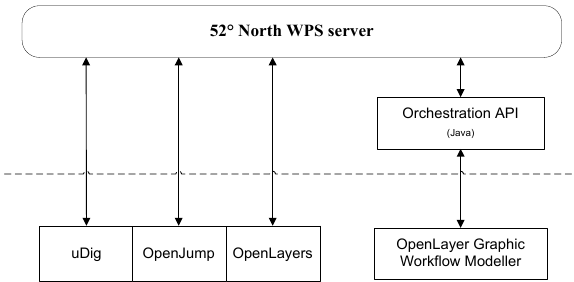
Figure 1. Depicts the architecture of the 52° North framework 52° North framework provides a WPS orchestration API and a graphical modelling tool for geoprocessing workflows based on the orchestration API (refer to figure 1). The modelling